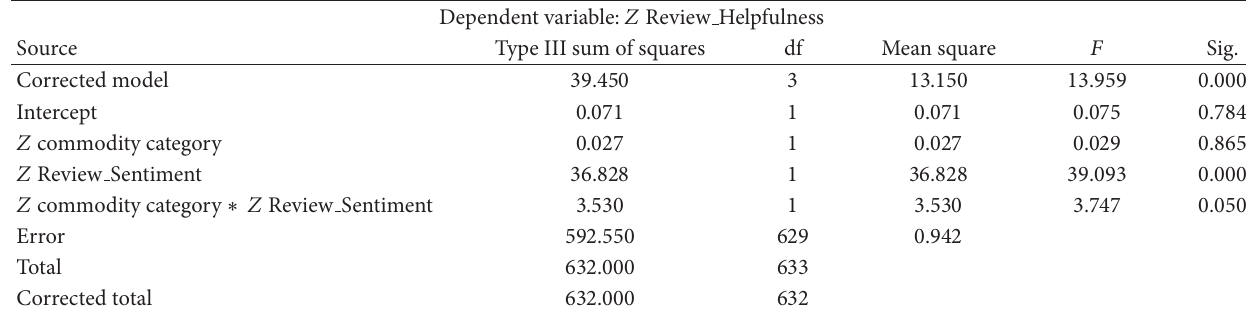
Table 10: Tests of between-subjects